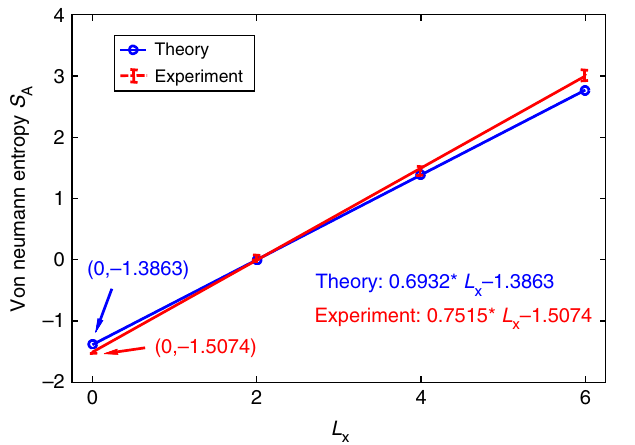
Fig. 2 The von Neumann entropies for the subsystem A of MESs | ψ 〉 4 , | ψ 〉 8 , and | ψ 〉 12 . Blue solid line is obtained from theoretic results, and red dotted dashed line represents experimental results. Error bars are de fi ned as